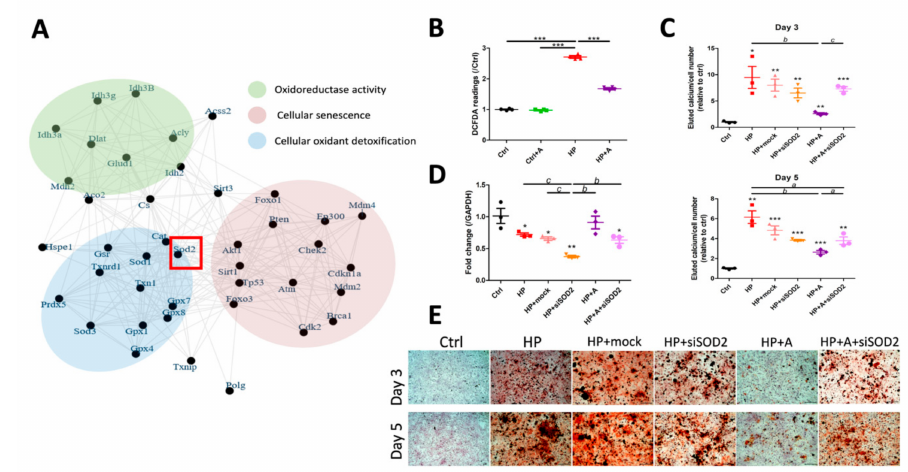
Figure 6. Functional characterization of SOD2. ( A ) A node plot illustrating the interactions between SOD2 and potential e ff ector pathways, divided according to the di ff erent spectrum of biologic processes. Red square denoted the validated core hub genes, SOD2. ( B ) VSMC ROS amount depending upon control or HP media with and without astaxanthin treatment. ( C ) Quantitation of calcification in SOD2 wild type or silenced cells with and without HP or astaxanthin exposure. ( D ) SOD2 mRNA expression levels and ( E ) microscopic examination images in each group. Scale bar, 200 µ m. * p < 0.05, ** p < 0.01, and *** p < 0.001 compared with Ctrl or the reference group; a p < 0.05, b p < 0.01, and c p < 0.001 for comparison. A, astaxanthin; Ctrl, control; DCFDA, 2 (cid:48) ,7 (cid:48) -dichlorofluorescin diacetate; HP, high phosphate; ROS, reactive oxygen species; siSOD2, SOD2 silenced group; VSMC, vascular smooth muscle